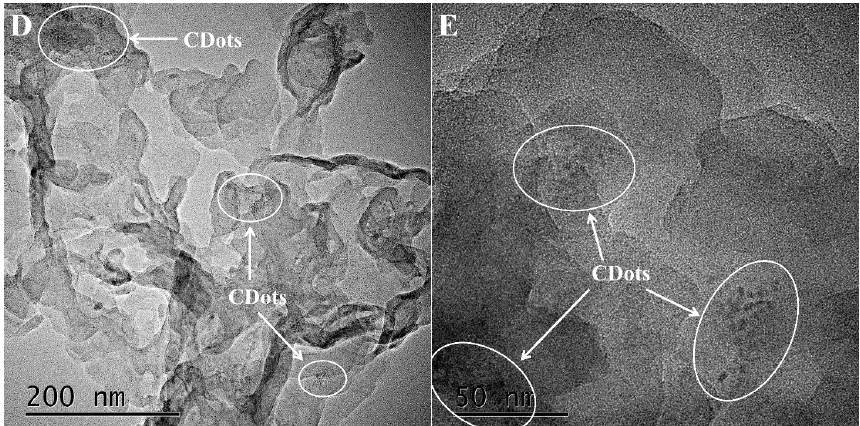
Figure 1. ( A ) Fourier Transform Infrared (FTIR) spectra; ( B ) X-Ray diffraction (XRD) patterns; ( C ) N 2 adsorption/desorption isotherm and pore width distribution of pure g-C 3 N 4 and CDots/g-C 3 N 4 composite; ( D , E ) Transmission electron microscopy (TEM) images of CDots/g-C 3 N 4 composite.